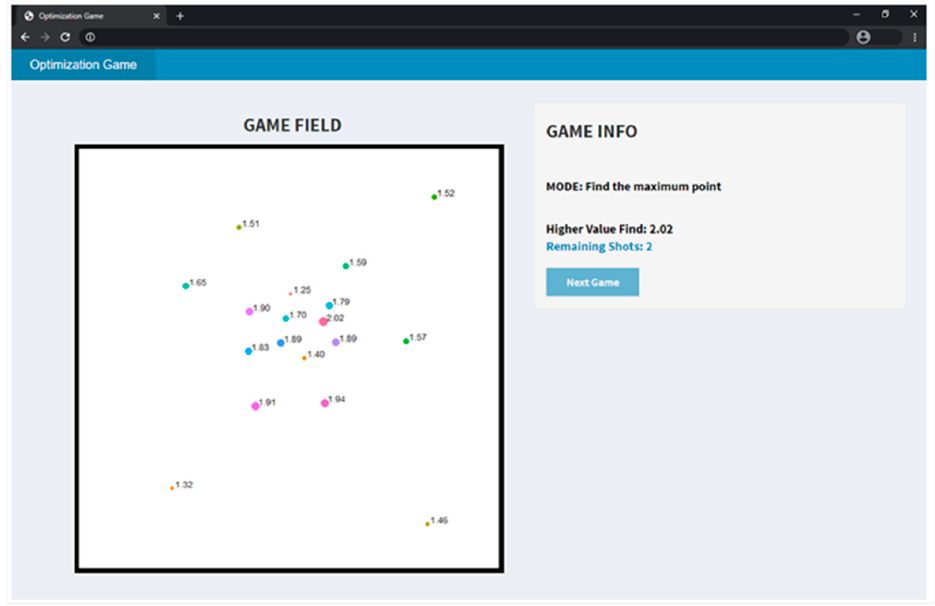
Figure 1. Web gaming app: an example of gameplay (source [5]).